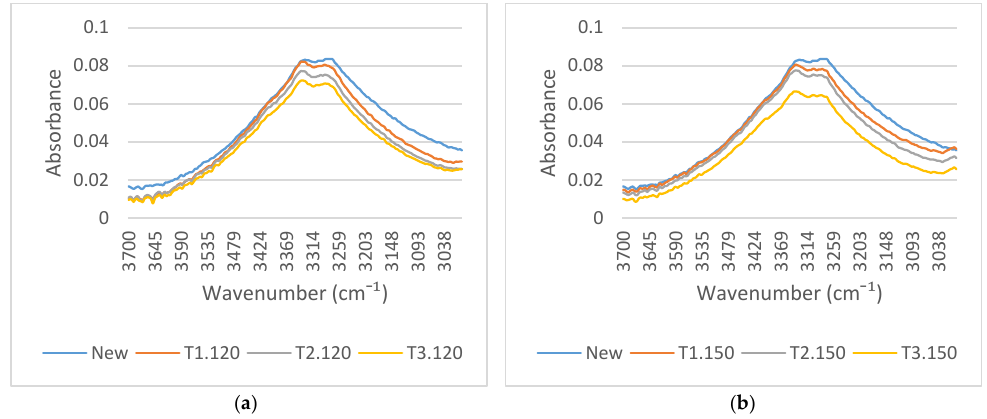
Figure 13. FTIR spectra at wavenumber 3700–3000 cm −1 of transformer insulation paper at aging temperature ( a ) 120 °C and ( b ) 150 °C.